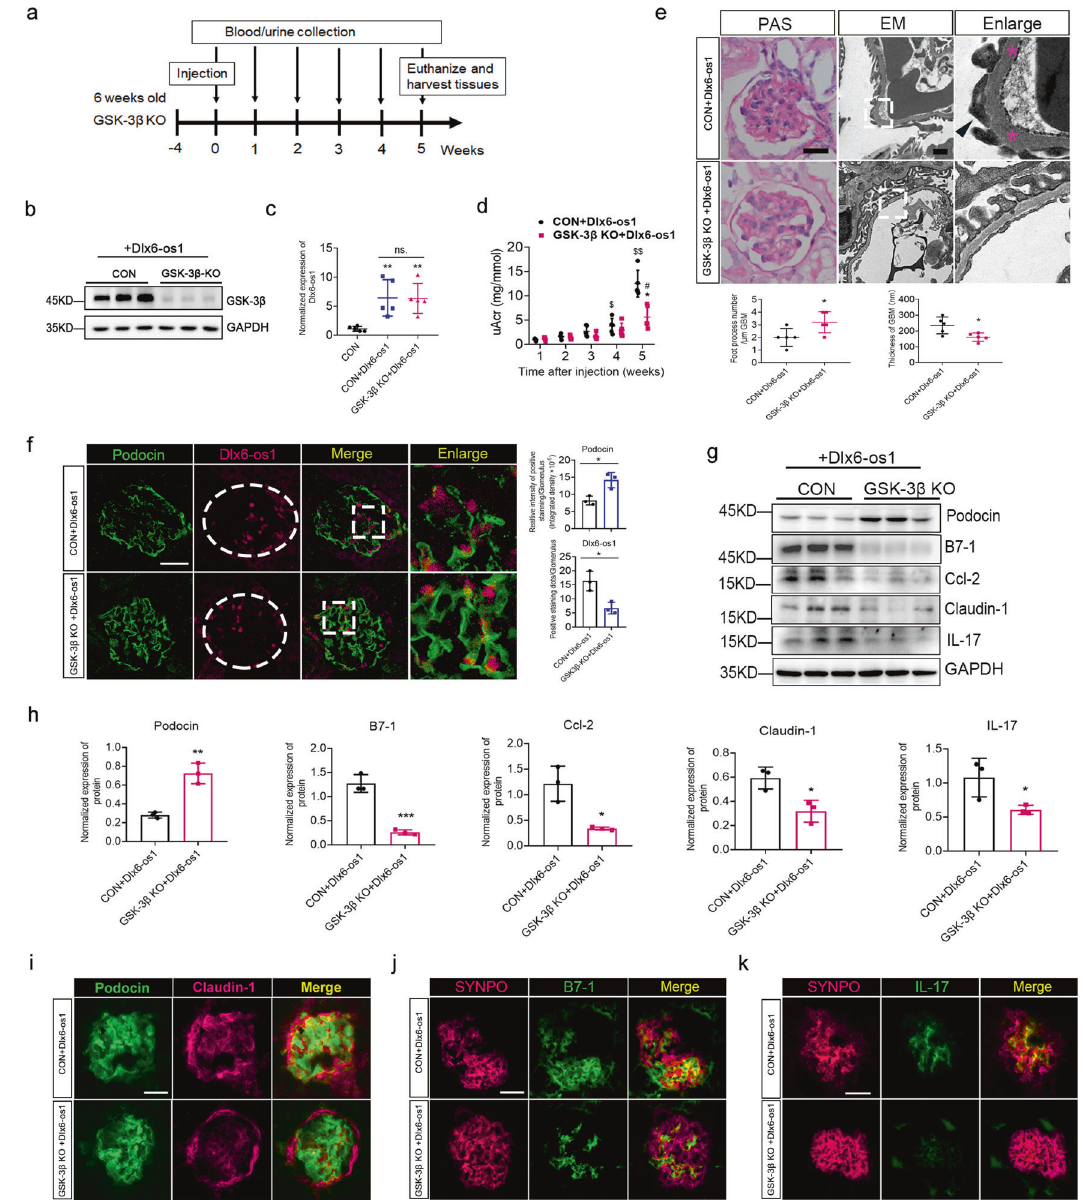
Fig. 8 LncRNA Dlx6-os1 inducing glomerular podocyte injury by regulating the GSK-3 β pathway, con fi rmed using podocyte-speci fi c GSK- 3 β -knockout (cKO) mice. a Flow chart of the model establishment, monitoring, and sampling. b Comparison of the GSK-3 β protein expression levels in glomeruli isolated from control ( fl ox/ fl ox) or GSK-3 β -KO mice. c Expression of lncRNA Dlx6-os1 in glomeruli of CON or GSK-3 β -KO mice injected with lncRNA Dlx6-os1-overexpression-lentivirus 5 weeks after injection assessed using qRT-PCR, compared to non-injected mice. ** P < 0.01 vs. CON; ns no signi fi cant difference (one-way ANOVA plus Dunnett ’ s multiple comparisons test). n = 5. d A comparison of the urinary albumin/creatinine ratio (uACR) values. $ P < 0.05 vs. (1-week CON + Dlx6-os1); $$ P < 0.01 vs. (1-week CON + Dlx6-os1); # P < 0.05 vs. (1-week GSK-3 β -KO + Dlx6-os1); * P < 0.05 vs. (5-week CON + Dlx6-os1). Two-way ANOVA plus Dunnett ’ s multiple comparisons test or Sidak ’ s multiple comparisons test ( n = 5 mice per group). e Periodic acid-Schiff (PAS) staining and electron microscopy (EM) showed improved pathology in the kidney tissues of GSK-3 β -KO mice, compared with the fl ox/ fl ox control. PAS bar = 20 µm; EM bar = 1 µm. Quanti fi cation is shown below the images ( n = 5). * P < 0.05 vs. (CON + Dlx6-os1) (unpaired t -test). f FISH detecting the expression and localization of lncRNA Dlx6-os1 (magenta), and immuno fl uorescence detecting podocin expression (green) in glomeruli of control and GSK-3 β -KO mice overexpressing Dlx6-os1. Images are representatives of three separate experiments. Bar = 20 µm. The intensity of the staining is quanti fi ed and compared in the different samples ( n = 3). * P < 0.05 (unpaired t -test). g Western blots of isolated glomeruli to detect the expression of podocyte markers (podocin), injury-associated protein claudin-1, and in fl ammatory factors in the lncRNA Dlx6-os1 overexpressed GSK-3 β -KO mice and control (CON) mice. Blots are representatives of three separate experiments and quanti fi cation is shown in h . h Quanti fi cation of the western blot data shown in g . The intensity of the bands was analyzed in ImageJ and normalized to that of GAPDH ( n = 3). * P < 0.05 (vs CON + Dlx6-os1), ** P < 0.01 (vs CON + Dlx6-os1), *** P < 0.01 (vs CON + Dlx6-os1) (unpaired t -test). i – k Immuno fl uorescence detecting the expression and localization of podocyte marker proteins (podocin, i , green; SYNPO, synaptopodin j , and k , magenta), injury protein claudin-1 ( i , magenta,) and in fl ammatory factors ( j , B7-1 green and k , IL-17, green) in glomeruli of control and GSK-3 β -KO mice overexpressing Dlx6-os1. Bar = 20 µm.